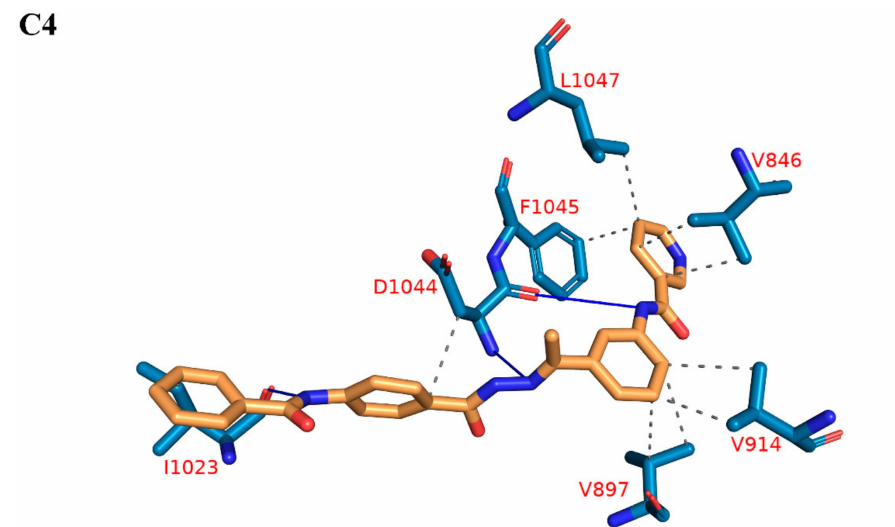
Figure 9. Shows the 3D interaction between the compound 10- VEGFR-2 complex in each of the representative frames for each cluster. Amino acids are shown as blue sticks. Compound 10 is shown as orange sticks. Grey dashed lines: hydrophobic interaction. Blue solid lines.